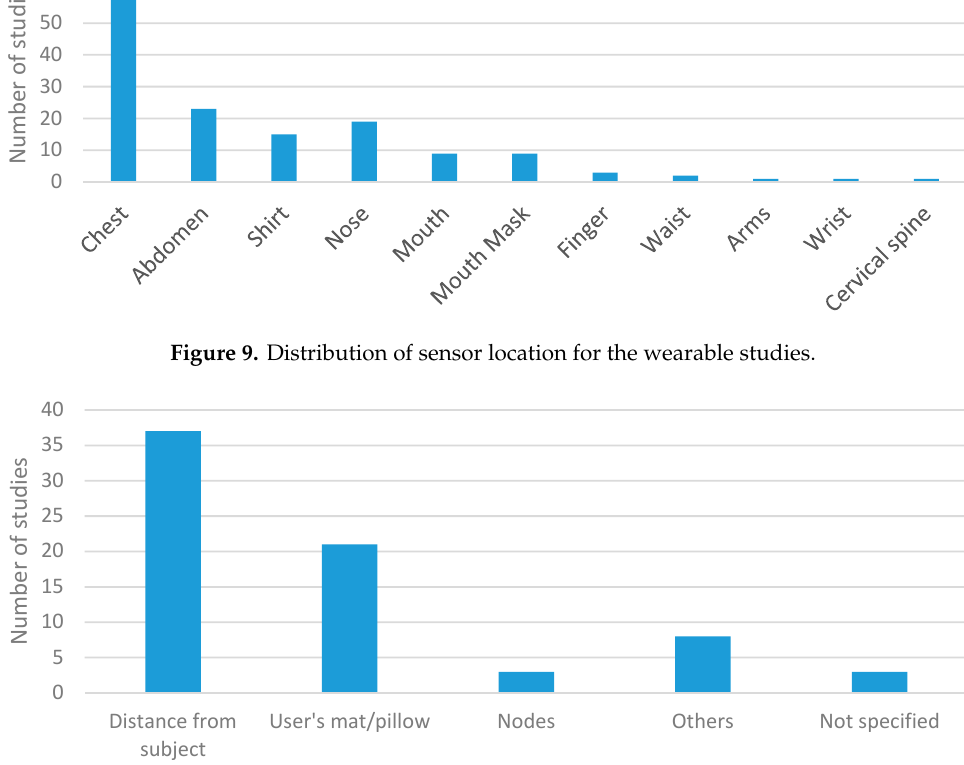
Figure 10. Distribution of sensor location for the environmental studies.